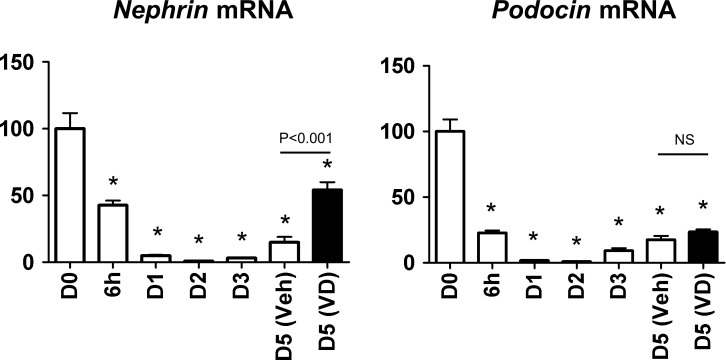
Expression of nephrin and podocin mRNA in cultured glomeruli.Gene expression was studied on days 0–5 (D0-D5) and at 6 hours (6h). Vitamin D (VD, 50 nM) or vehicle (Veh) was added for the last two days. Expression levels were normalized by 18S ribosomal RNA and levels at D0 were defined as 100%. Mean±SEM of n = 5. Treatment with VD significantly upregulated nephrin expression by unpaired t test. NS, not significant. *P<0.001 vs D0 by one-way ANOVA with Dunnett’s post hoc test.